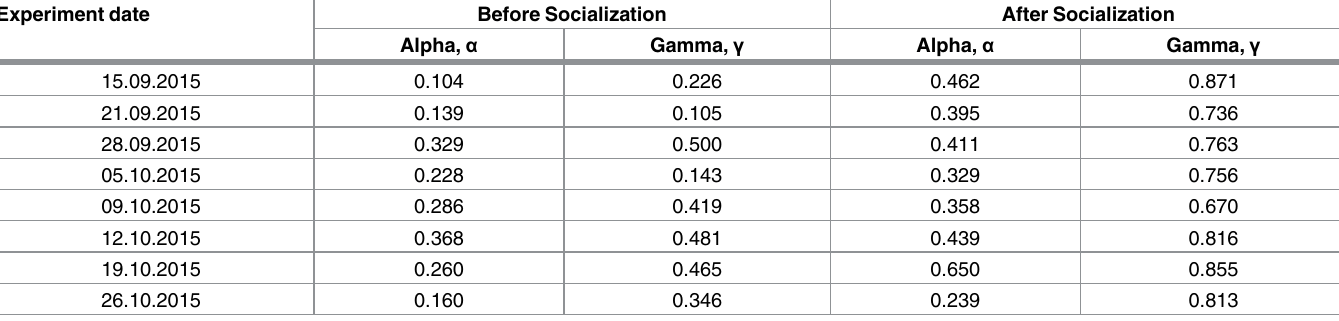
Table 6. Assessment of the parameters of reciprocal Socialization and tolerance to defection according to the results of the experiments before and after Socialization. Experiment date Before